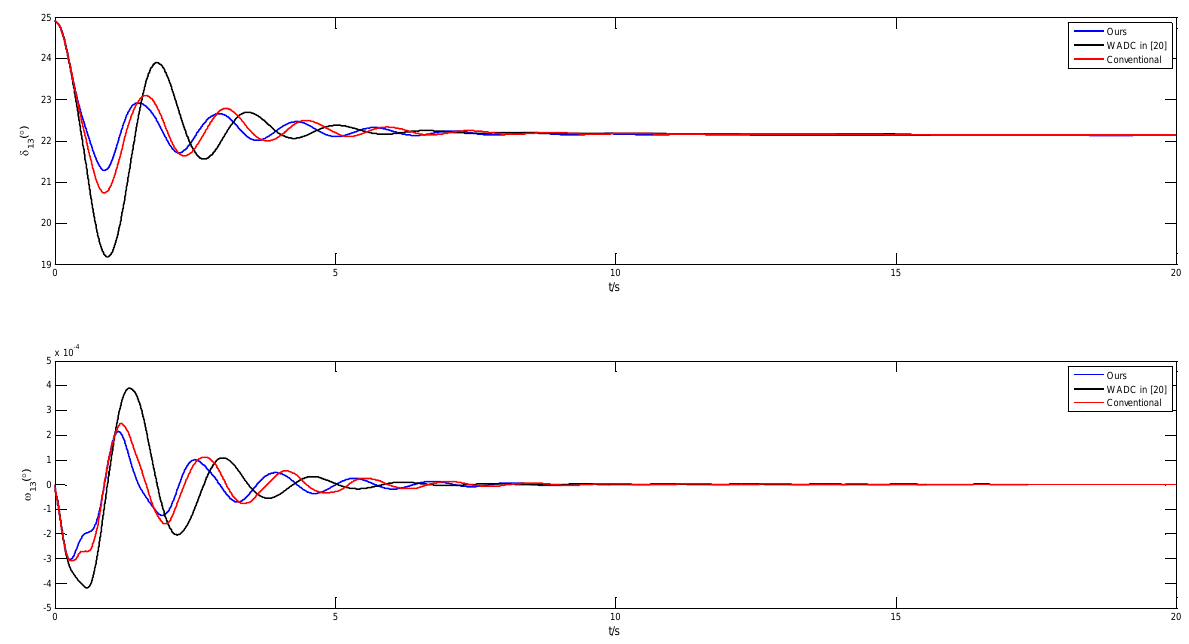
Figure 10. Response of the system in Scenario 3 when ρ = 0.3. Table 4. The key index of the response curve in case of packet loss. Figure No. Controller Overshot (dec \ pu) Ours 33.437 \ 9.276 × 10 − 4 WADC in [20] 34.550 \ 9.912 × 10 − 4 Figure 8 Conventional 33.357 \ 9.263 × 10 − 4 Ours 25.891 \ 1.100 × 10 − 3 WADC in [20] 28.843 \ 6.625 × 10 − 4 Figure 9 Conventional 26.400 \ 8.973 × 10 − 4 Ours 24.900 \ 2.136 × 10 − 4 WADC in [20] 24.900 \ 3.880 × 10 − 4 Figure 10 Conventional 24.900 \ 2.459 × 10 −